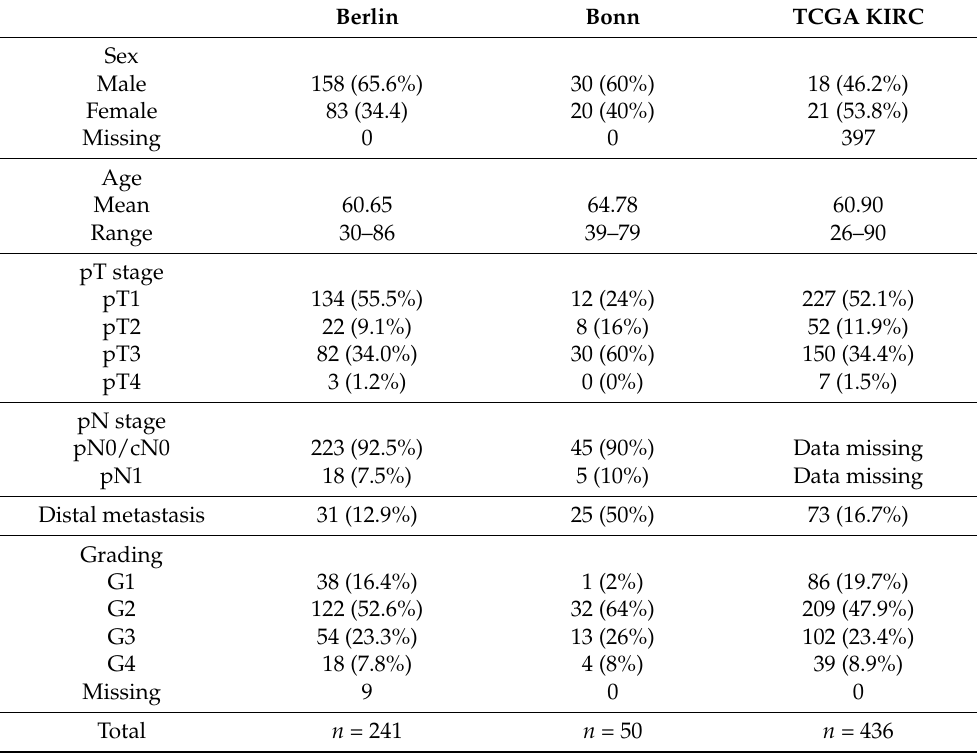
Table 1. Patient characteristics of both cohorts (Bonn and Berlin) and